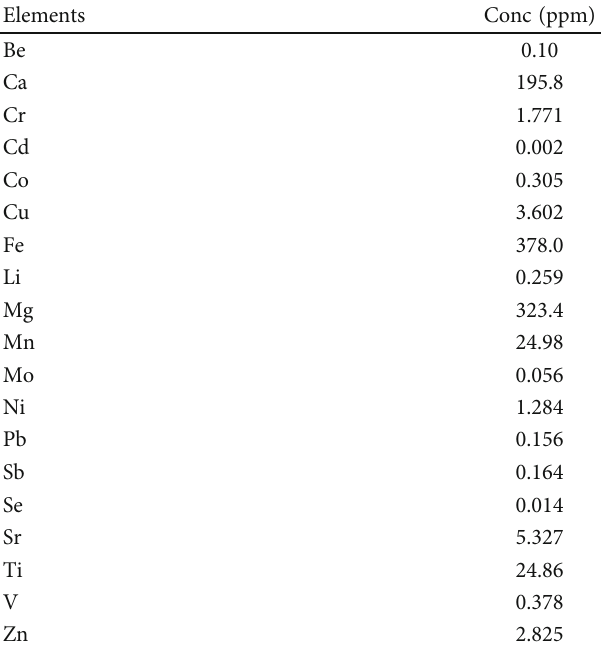
Table 1: Concentration of heavy metals and other trace elements in the incense stick ash analyzed by inductively coupled plasma- optical emission spectroscopy (ICP-OES), adopted from [11].